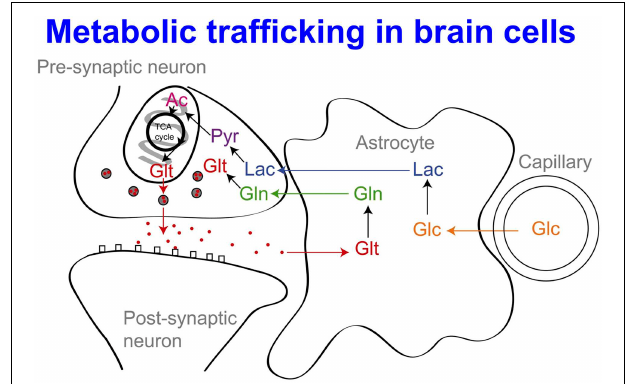
FIGURE 9 | Glucose (Glc) from the vasculature is metabolized to lactate (Lac) in astrocytes, exported into the extracellular fluid, taken up by neurons and processed [via pyruvate (Pyr) and acetate (Ac)] by the TCA cycle. This spins off glutamate (Glt), which is released and then taken up by astrocytes, which convert it to glutamine (Gln), which is released into the extracellular fluid and taken up by neurons, which re-convert it to glutamate. For details of the relevant membrane transporters (see Chih and Roberts, 2003; Gallagher et al., 2009; Pellerin and Magistretti, 2012). Besides Lac production in situ from Glc, Lac may also be taken up from the circulation, (see Ide et al., 2000; Overgaard et al., 2012; Jalloh et al., 2013). For typical concentrations of the above species and PbtO 2 (see Gallagher et al., 2009; Timofeev et al., 2011a,b ). Originally published by Gallagher et al. (2009) in Brain 132: 2839–2849, and reproduced with permission of Oxford Journals.